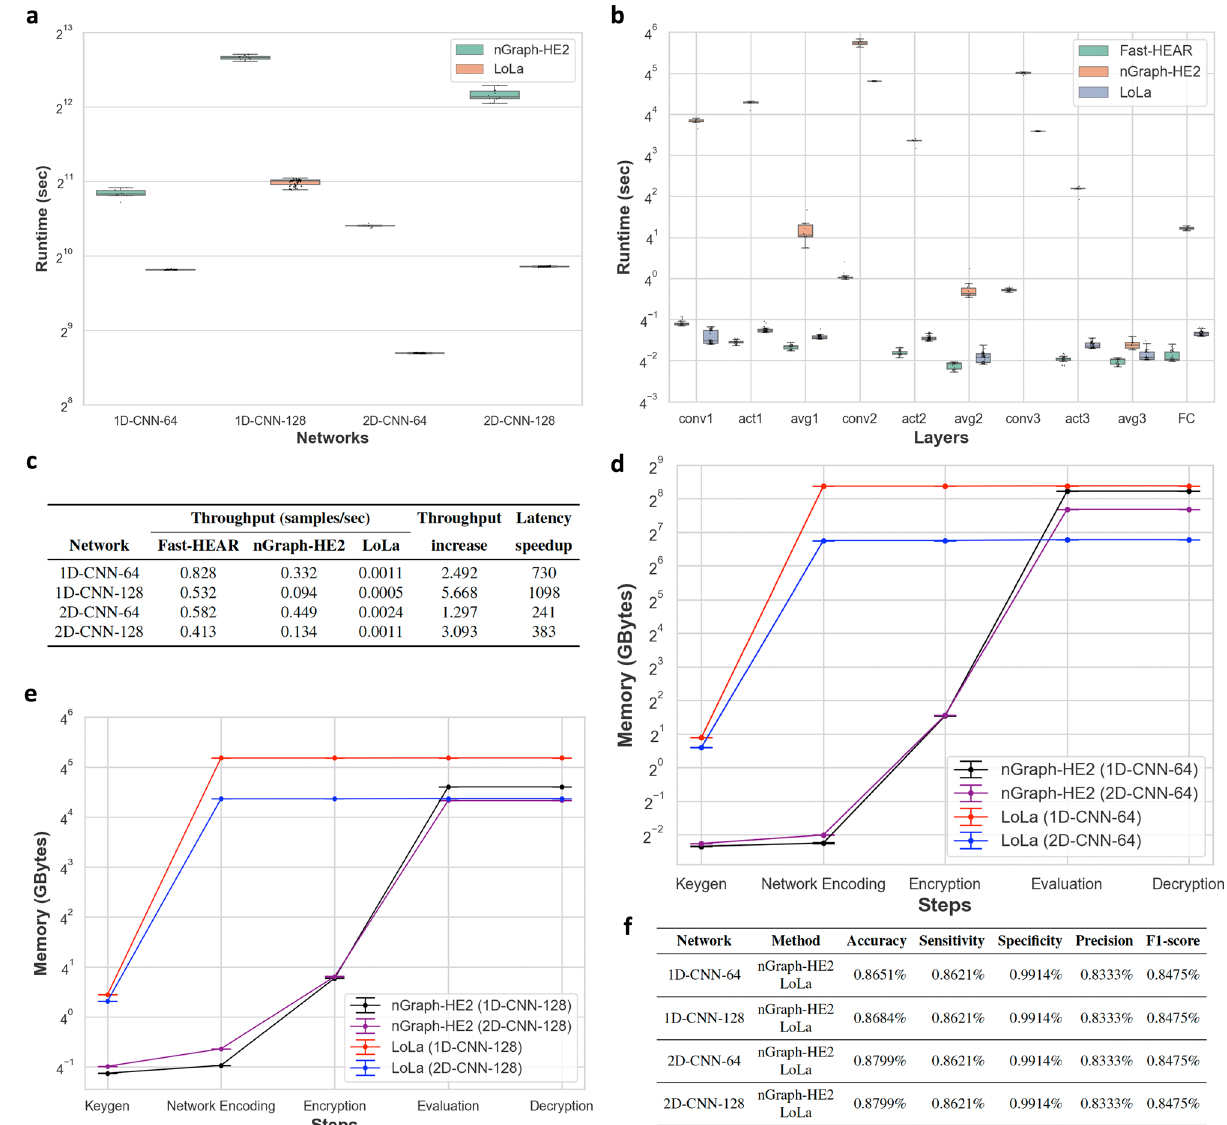
Fig. 5 | Comparison with state-of-the-art methods. a , b Boxplots display the median values with the fi rst and third quartiles, and the whiskers boundaries represent the largest and smallest data values no morethan 1.5 times the IQRfrom thecorrespondinghinge.AveragerunningtimeforsecureinferenceofnGraph-HE2 (from n =10 independent experiments) and LoLa (from n =50 independent sam- ples) over various neural network models ( a ). Detailed average running time for each step in secure inference of Fast-HEAR (from n =50 independent samples), nGraph-HE2 (from n =10 independent experiments), and LoLa (from n =50